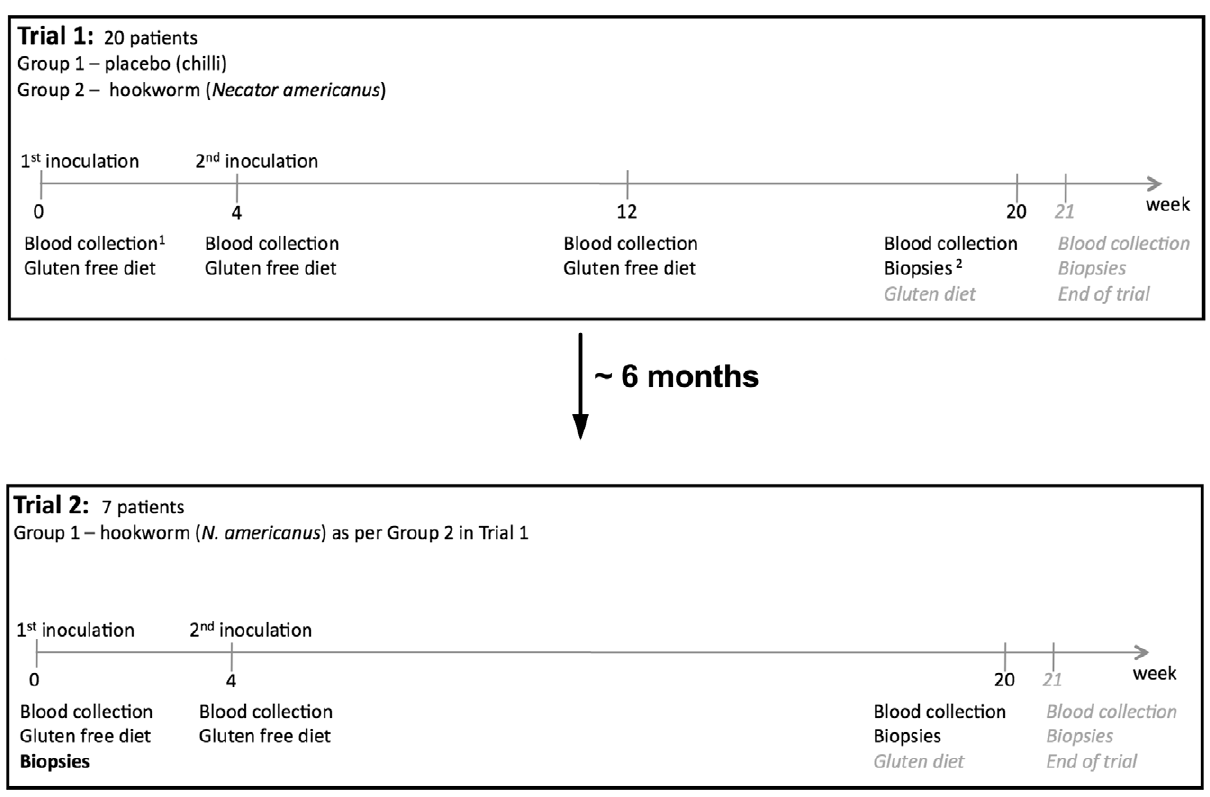
Figure 1. Trial design. For Trial 1, 20 patients were chosen according to selection criteria [21] and divided into two groups of 10, placebo control and hookworm infected (HW). All 20 patients completed the trial. For Trial 2, seven of the 10 patients from Group 1 in Trial 1 (placebo) chose to participate in the next trial and received hookworm infection and gluten challenge in an identical manner to that described for Group 2 in Trial 1. The only difference was that gut biopsies were taken at week 0 (prior to hookworm infection; denoted in bold font) in addition to biopsies taken at weeks 20 and 21. For the purposes of this study, sample collection ceased at week 20 (prior to gluten administration) and tissues from week 21 were not utilized, except for samples taken from the worm attachment site which were collected at week 21; week 21 tissues were critical for assessment of the effect of hookworm on the anti-gluten response in celiac disease and are therefore highlighted in italicised grey font and have been reported in relevant publications [21,22]. 1 Forty millilitres of blood per person were collected at weeks 0, 4, 12 (Trial 1 only), 20 and 21. 2 Gut biopsies were taken at weeks 0 (Trial 2 only), 20 (pre-gluten ingestion) and 21 (post-gluten ingestion) using a gastroscope as described elsewhere [21].